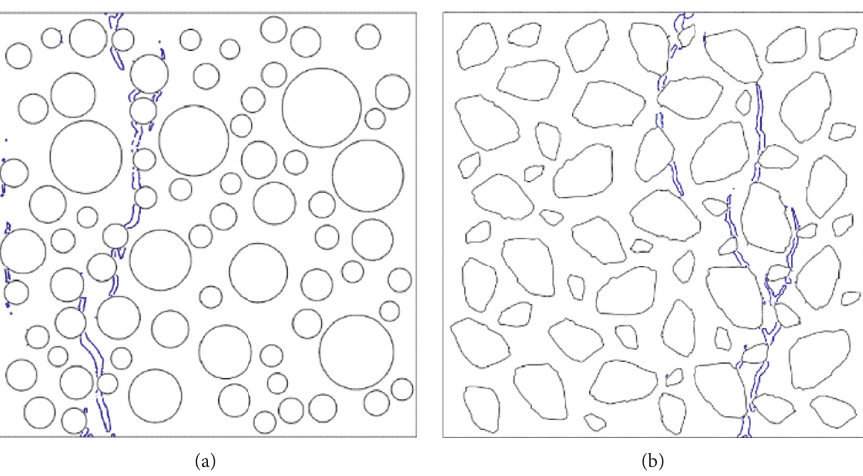
Figure 11: Uniaxial tensile specimen crack distribution. (a) Circle aggregate model. (b) Actual aggregate model.